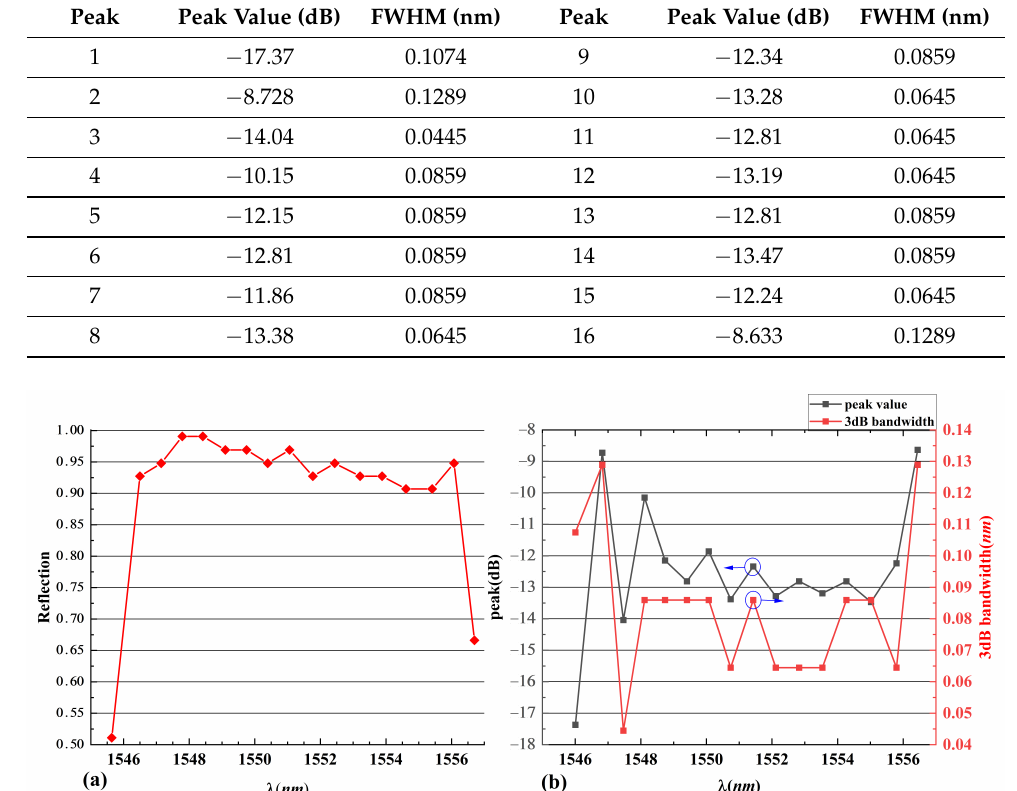
Figure 13. ( a ) Peak reflectivity of the 17 wavelength channels of the 2D CFBG. ( b ) The peak value and 3dB bandwidth at different transmission peaks in the reflection spectrum of a 2D